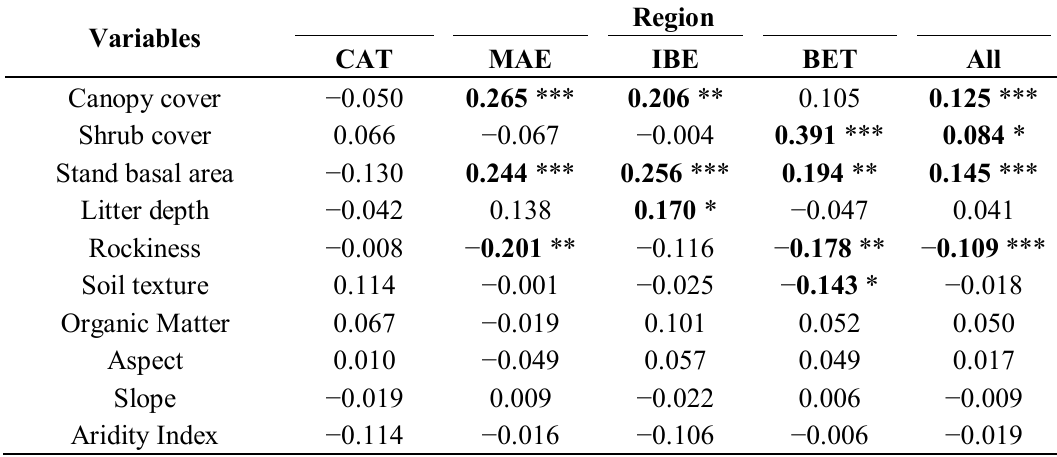
Table 2. Spearman rank correlations between biotic and abiotic variables, and seedling density across the four study regions; significant results are noted in